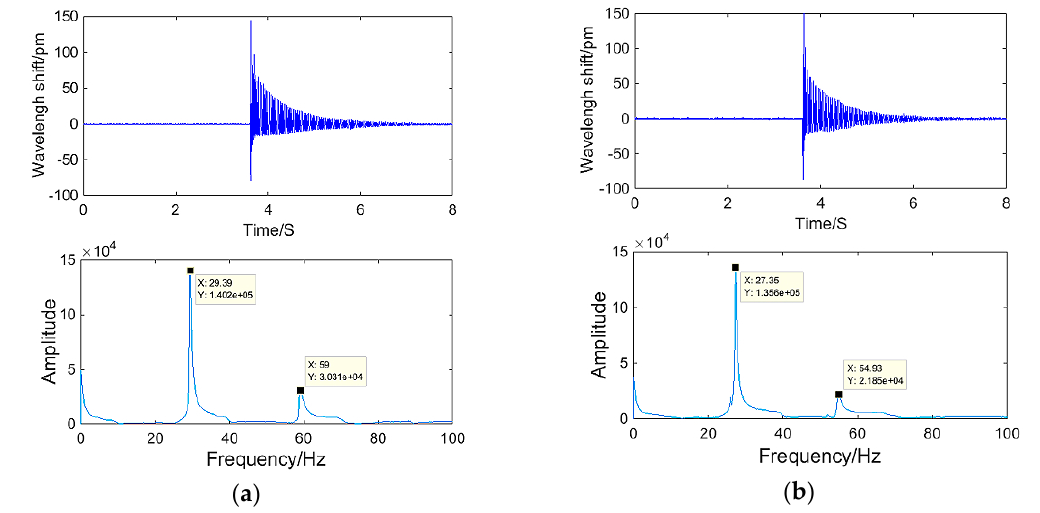
Figure 9. Time domain and spectrum map of ( a ) #1 mass ball and ( b ) #2 mass ball optical fiber systems.